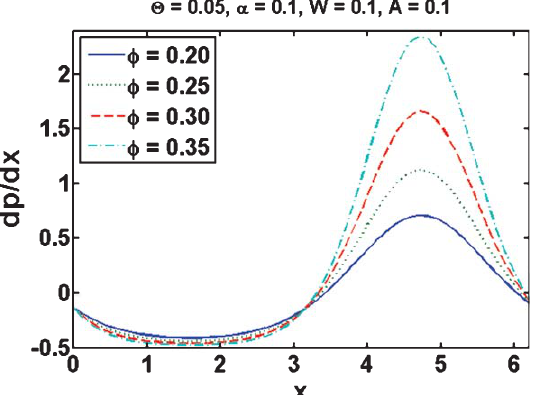
Fig. 10. Variation in dp/dx against x for different values of slip parameter ( α ).